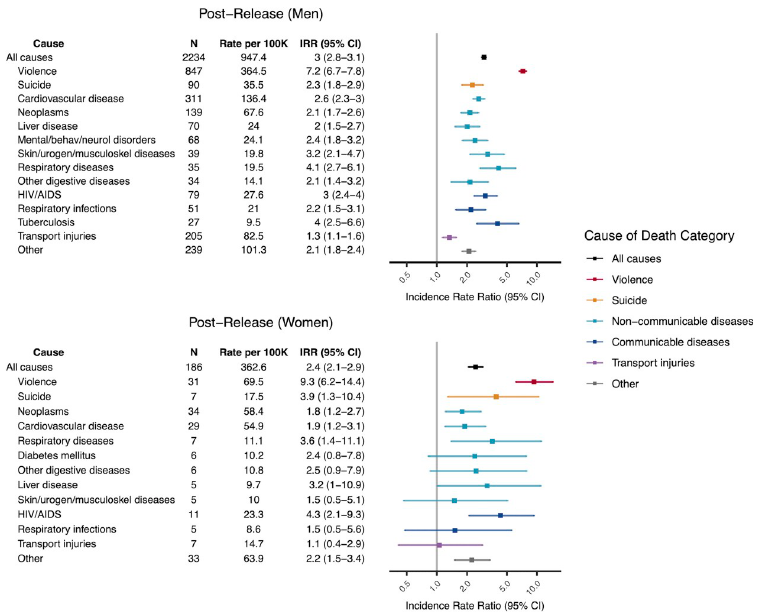
Fig 4. Age-standardized mortality rates among formerly incarcerated men and women. All-cause and cause- specific mortality rates and IRRs for the leading causes of death among formerly incarcerated men and women. Rates were directly standardized to the age structure for incarcerated men or women. IRRs were computed relative to non- incarcerated male or female Mato Grosso do Sul residents. Colors correspond to broad cause of death categories. Within each category, causes are ordered by number of deaths. A total of 2 deaths of formerly incarcerated men were excluded due to missing age information. 100K, 100,000 person-years; IRR, incidence rate ratio; N , number of deaths; mental/behav/neurol disorders, mental/behavioral, neurological, and sensory organ disorders; skin/urogen/ musculoskel diseases, skin/genitourinary/musculoskeletal diseases.